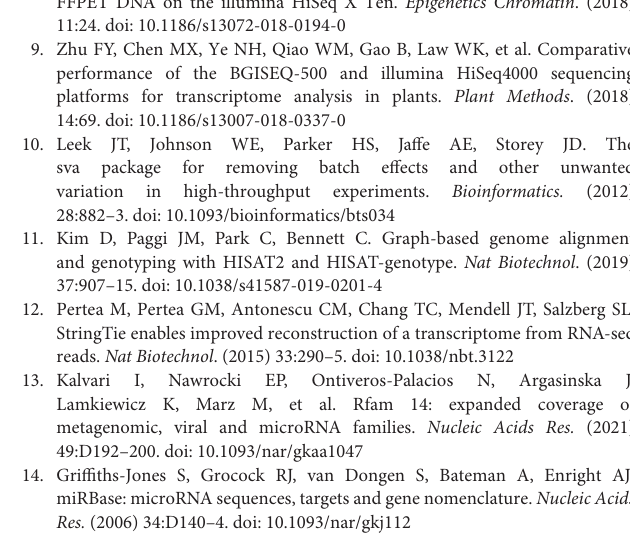
Supplementary Figure 1 | The in vitro qPCR validation of IL18R1, IL1R2, LRG1, and RNASE1 in additional HF and MF patients. ∗ p <